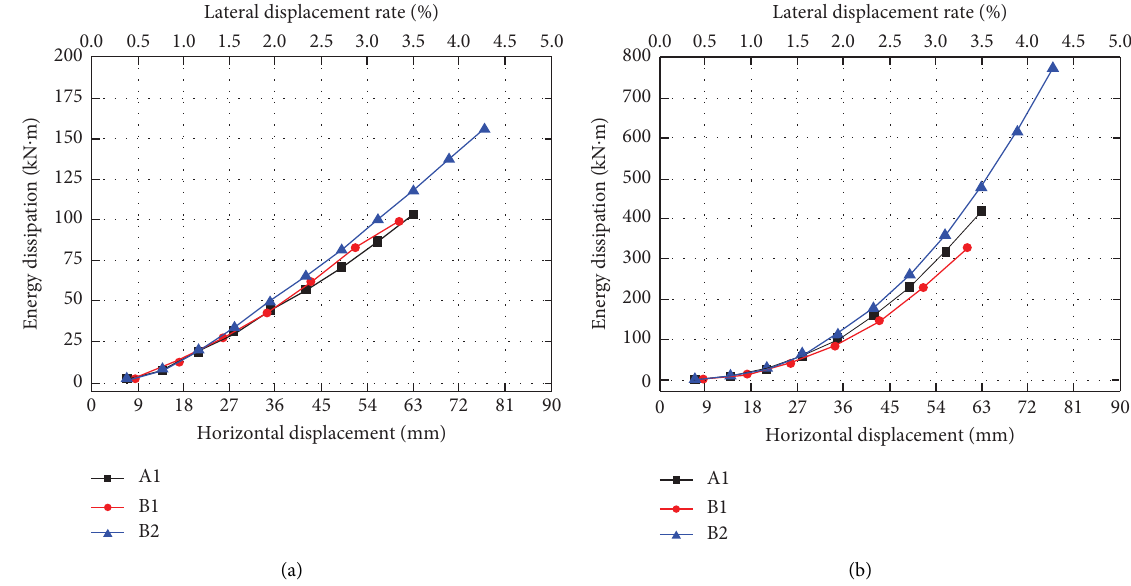
Figure 10: Energy dissipation capacity of each specimen. (a) Energy dissipation of each displacement level. (b) Cumulative hysteretic energy